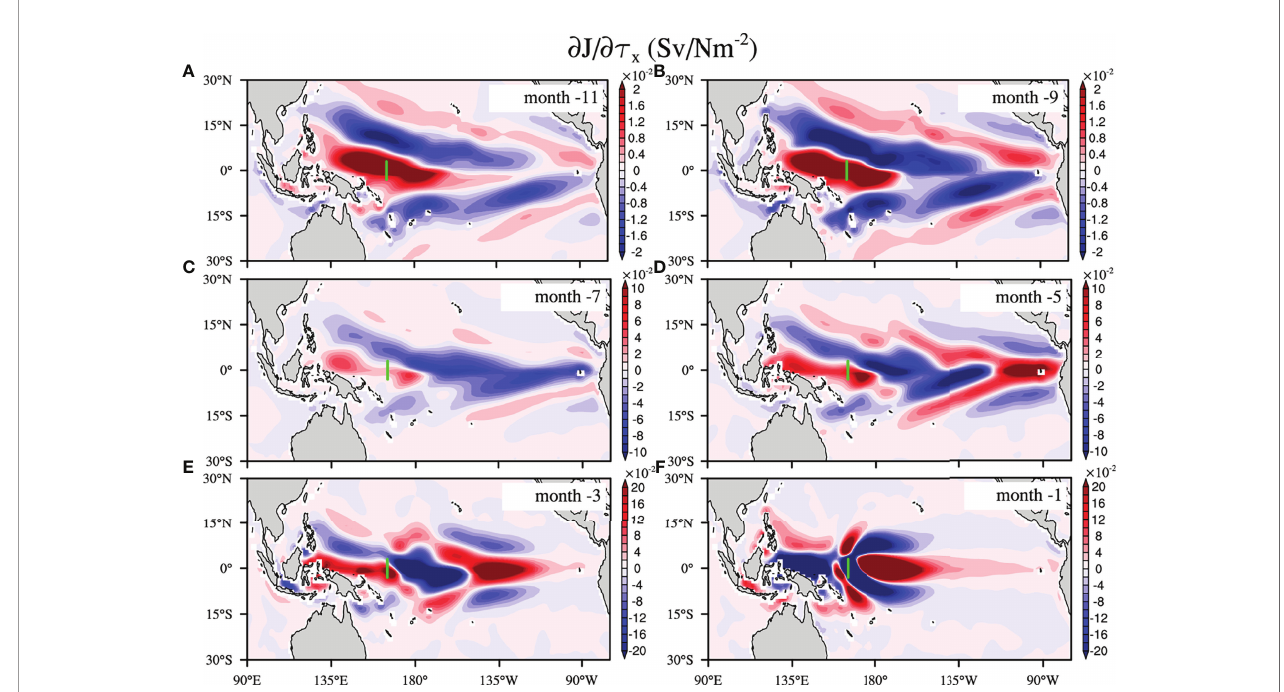
FIGURE 3 | Monthly adjoint sensitivity (Sv/Nm -2 ) of the EUCT in July to the zonal wind stress from previous 11 to 1 months (marked as A – F , respectively). Note that the representative values of color bars are gradually increasing with different months.